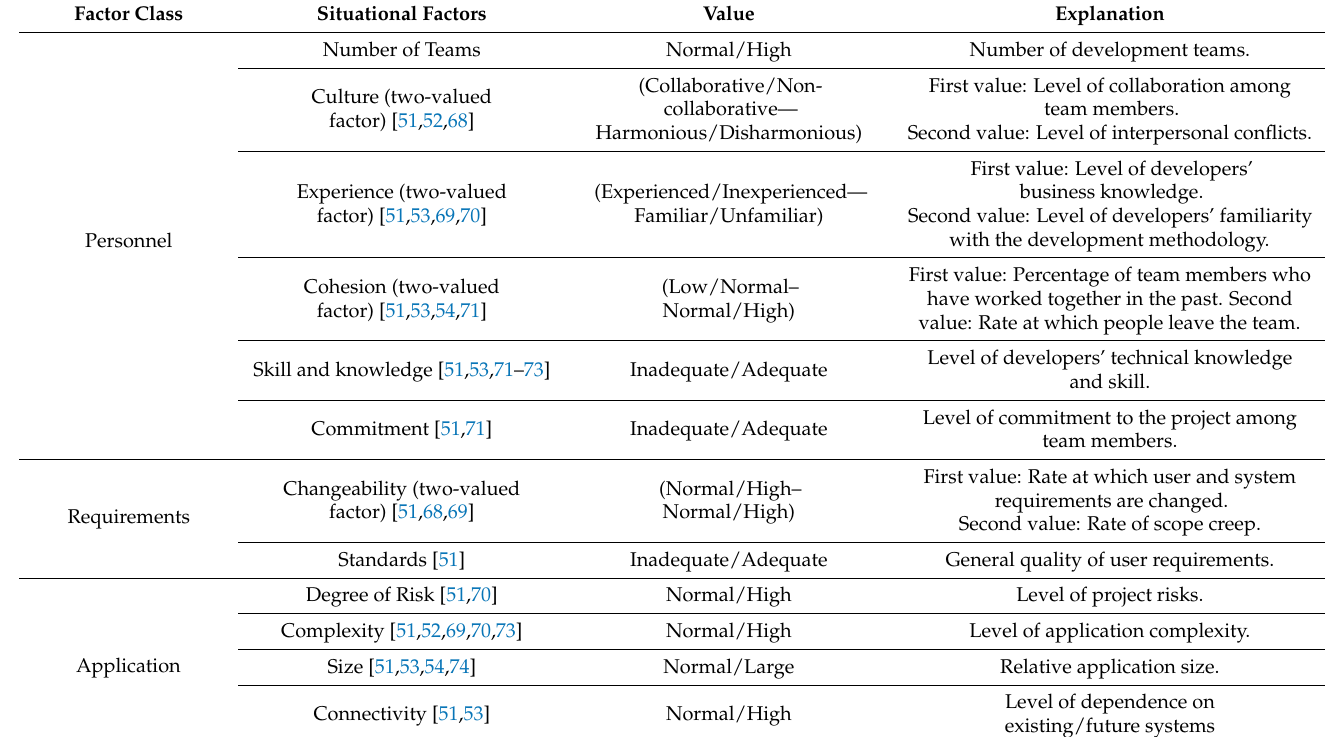
Table 2. Situational factors (context attributes) relevant to agile